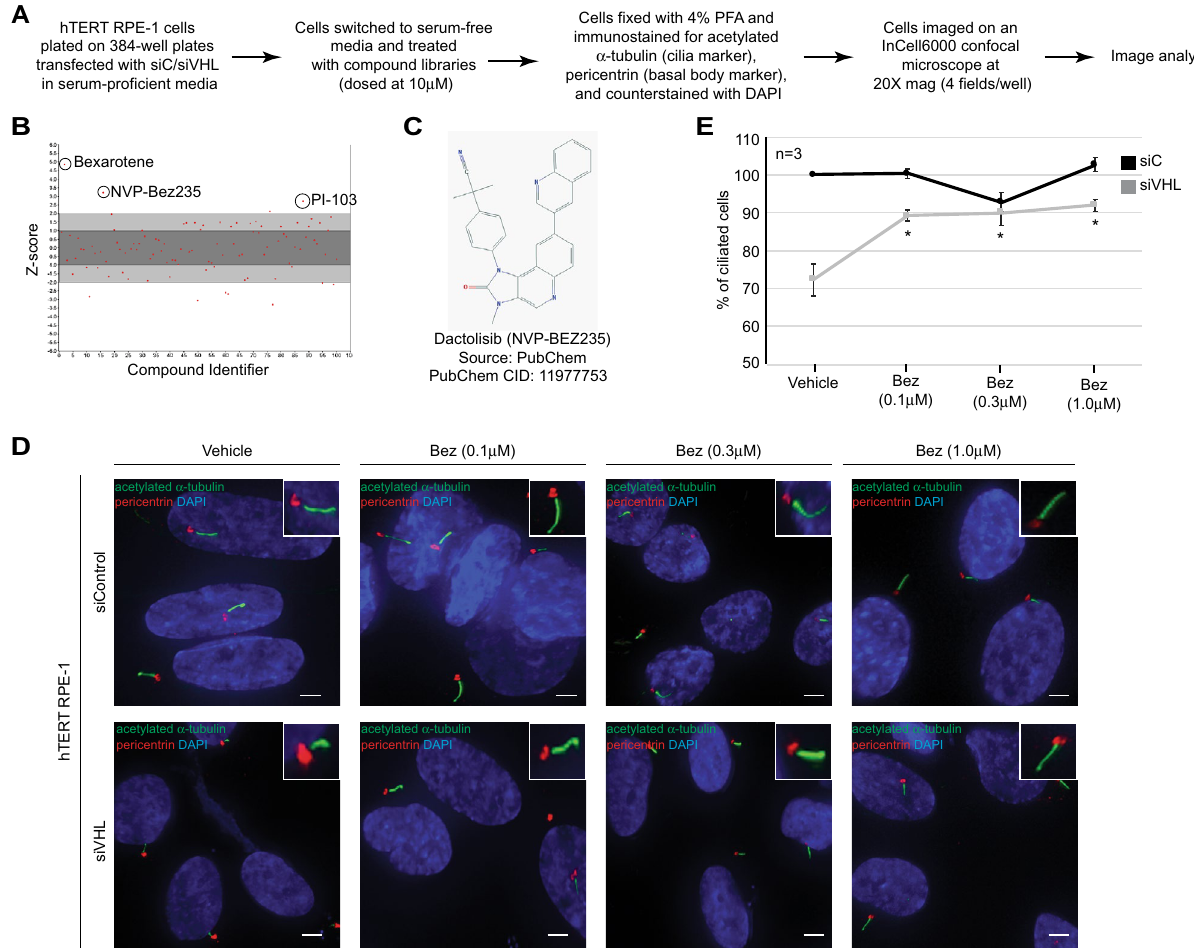
Figure 1. NVP-BEZ235 regulates ciliogenesis in VHL -deficient cells. ( A ) Workflow used for the image-based screening assay. ( B ) Graphical representation showing the Z-score of compounds used in the screen. The compounds annotated with names were identified as positive hits. ( C ) Chemical structure of NVP-BEZ235. ( D ) Representative images (60X magnification) of hTERT RPE-1 cells transfected with siC (scrambled control) or siVHL showing acetylated α-tubulin (cilia marker, green) and pericentrin (basal body marker, red). Nuclei are counterstained with DAPI in blue. Insets show a magnified image of a cilium for each of the treatment conditions. Scale bar, 10 μM. ( E ) Graphical representation of the percentage of ciliated cells treated with Vehicle or NVP-BEZ235 (Bez) at the indicated doses in VHL -proficient (siC, black line) and VHL -deficient (gray line) cells. *Statistical significance (Students t-test) compared to vehicle (DMSO) treated control (p <